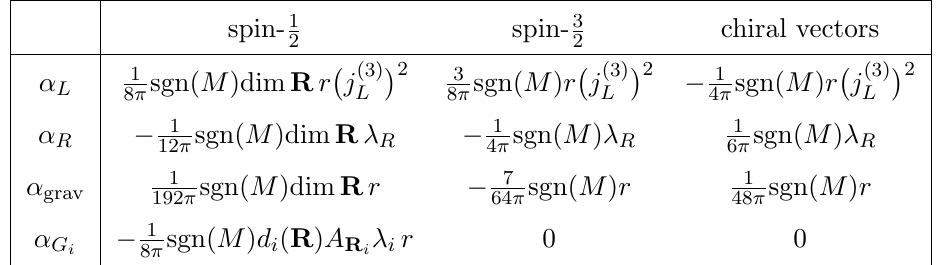
; j R ; R ) of u (1) L L (cid:8)